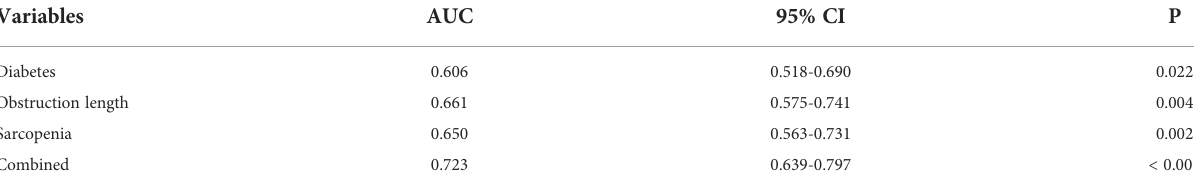
TABLE 4 ROC analysis of risk factors for EBI in patients after PTBS placement.